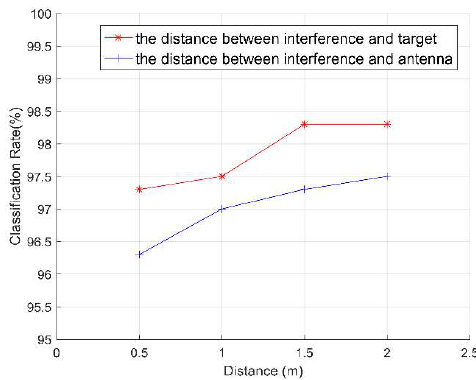
Figure 13. Classification rate of two types of distances.